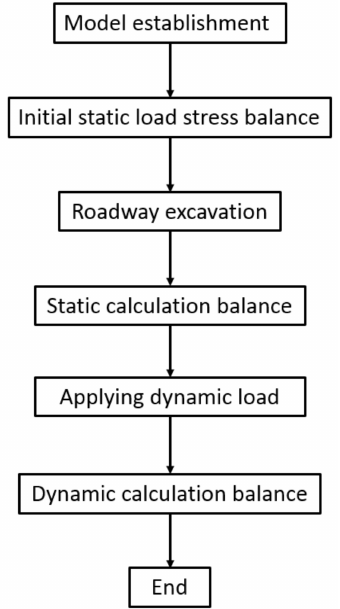
Figure 6. Flow chart of the numerical simulation